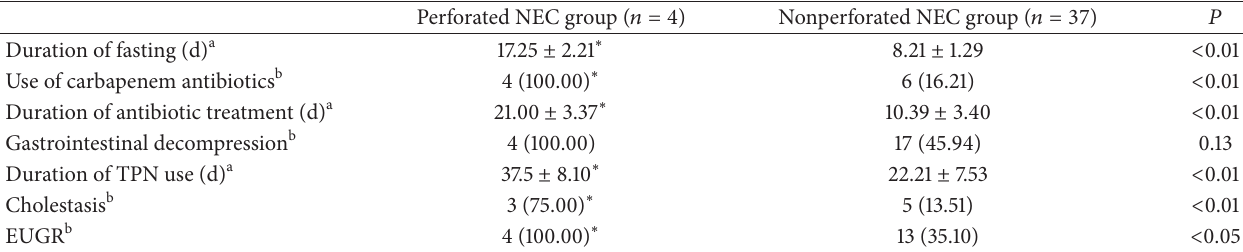
Table 4: Treatments and complications in NEC infants with and without bowel perforation.